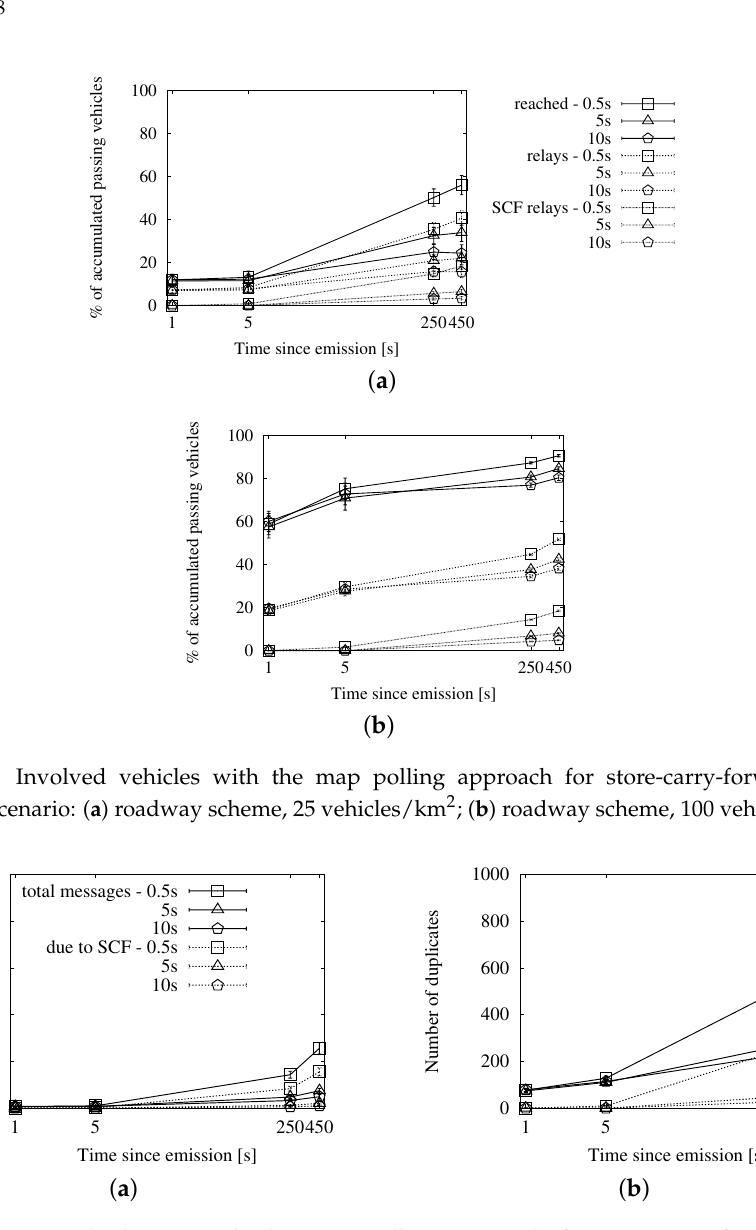
Figure 14. Sent duplicates with the map polling approach for store-carry-forward in the New York scenario: ( a ) roadway scheme, 25 vehicles/km 2 ; ( b ) roadway scheme, 100 vehicles/km 2 .